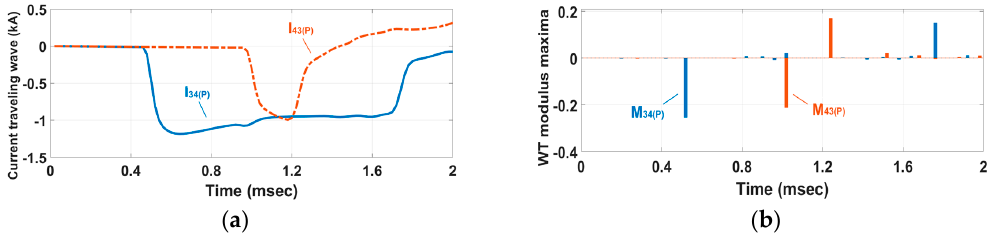
Figure 13. ( a ) Waveforms of current traveling waves at both ends of the positive line in the segment L 34 ; ( b ) Waveforms of their corresponding WT modulus maxima. Table 1. Simulation results of WT modulus maxima.